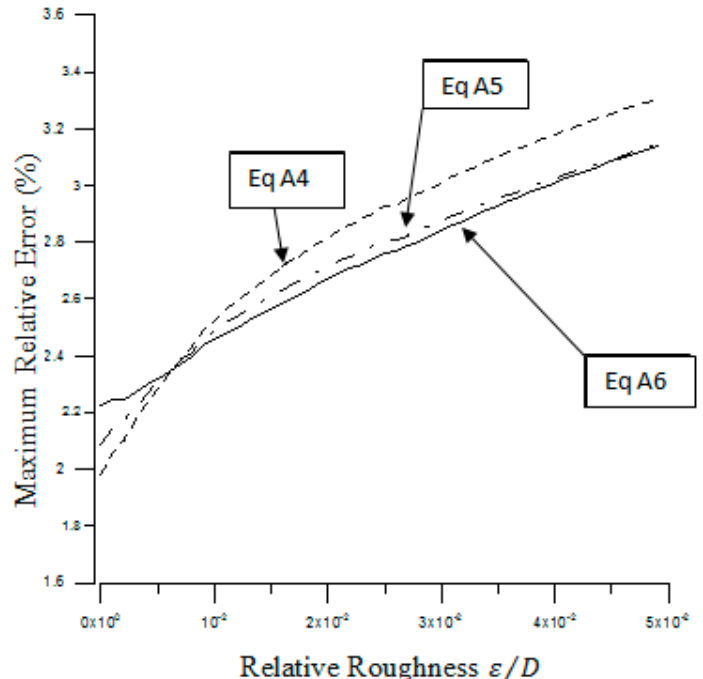
Figure 4. The maximum deviation (in percent) for versus different relative roughness. Values of Equations: A4–A6 using B of Equation (A7).